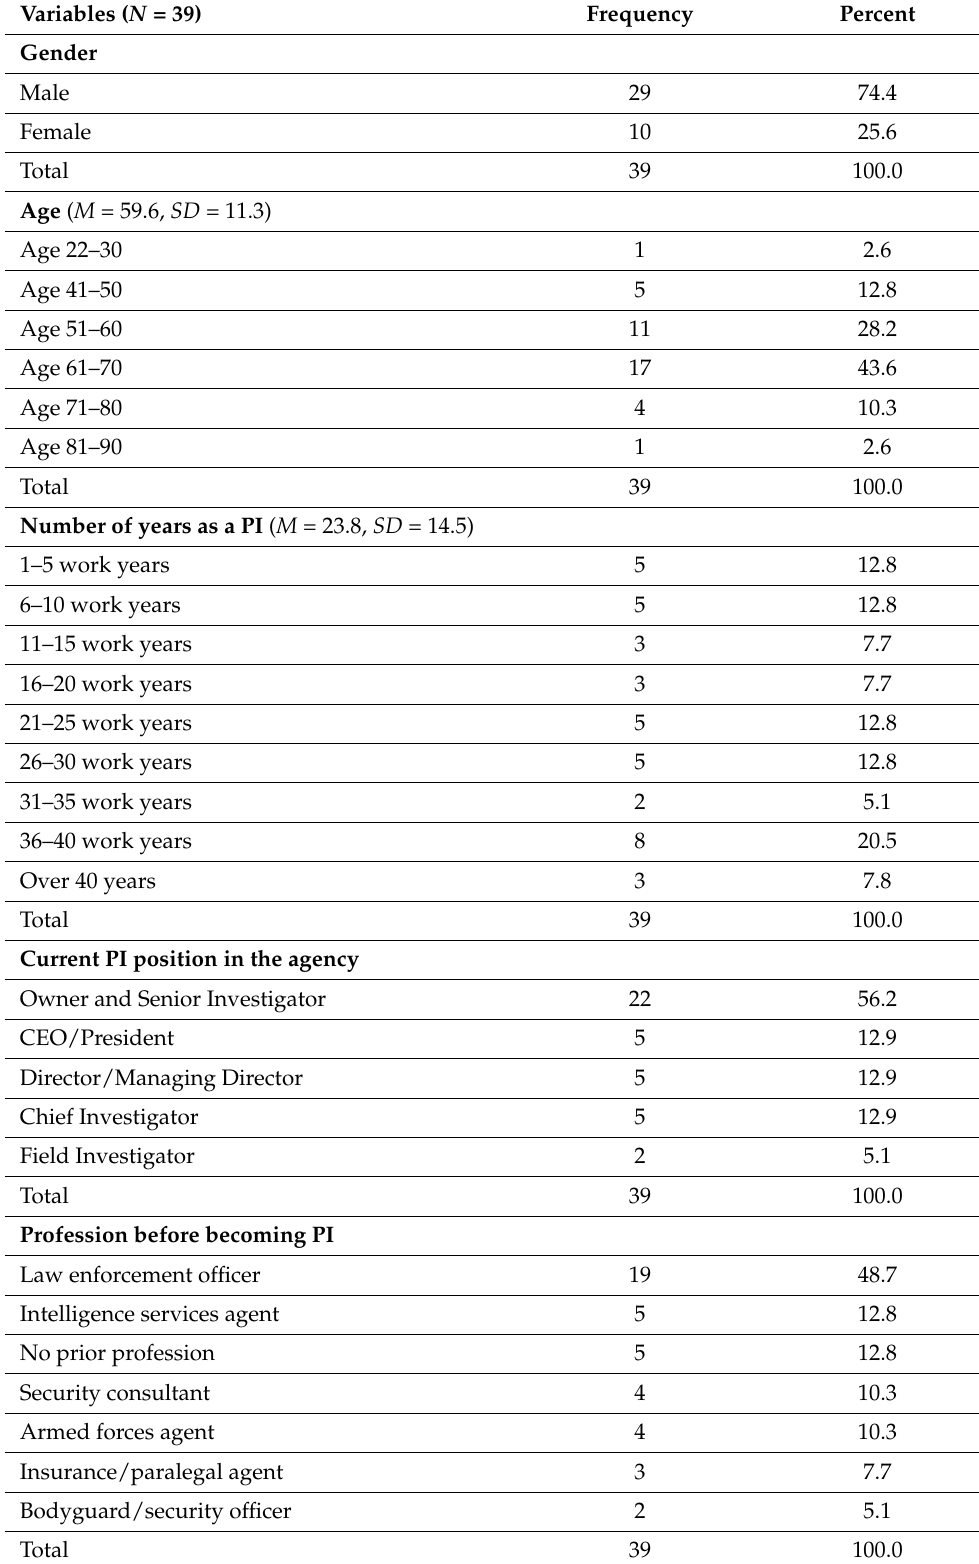
Table 1. Survey participants’ demographics